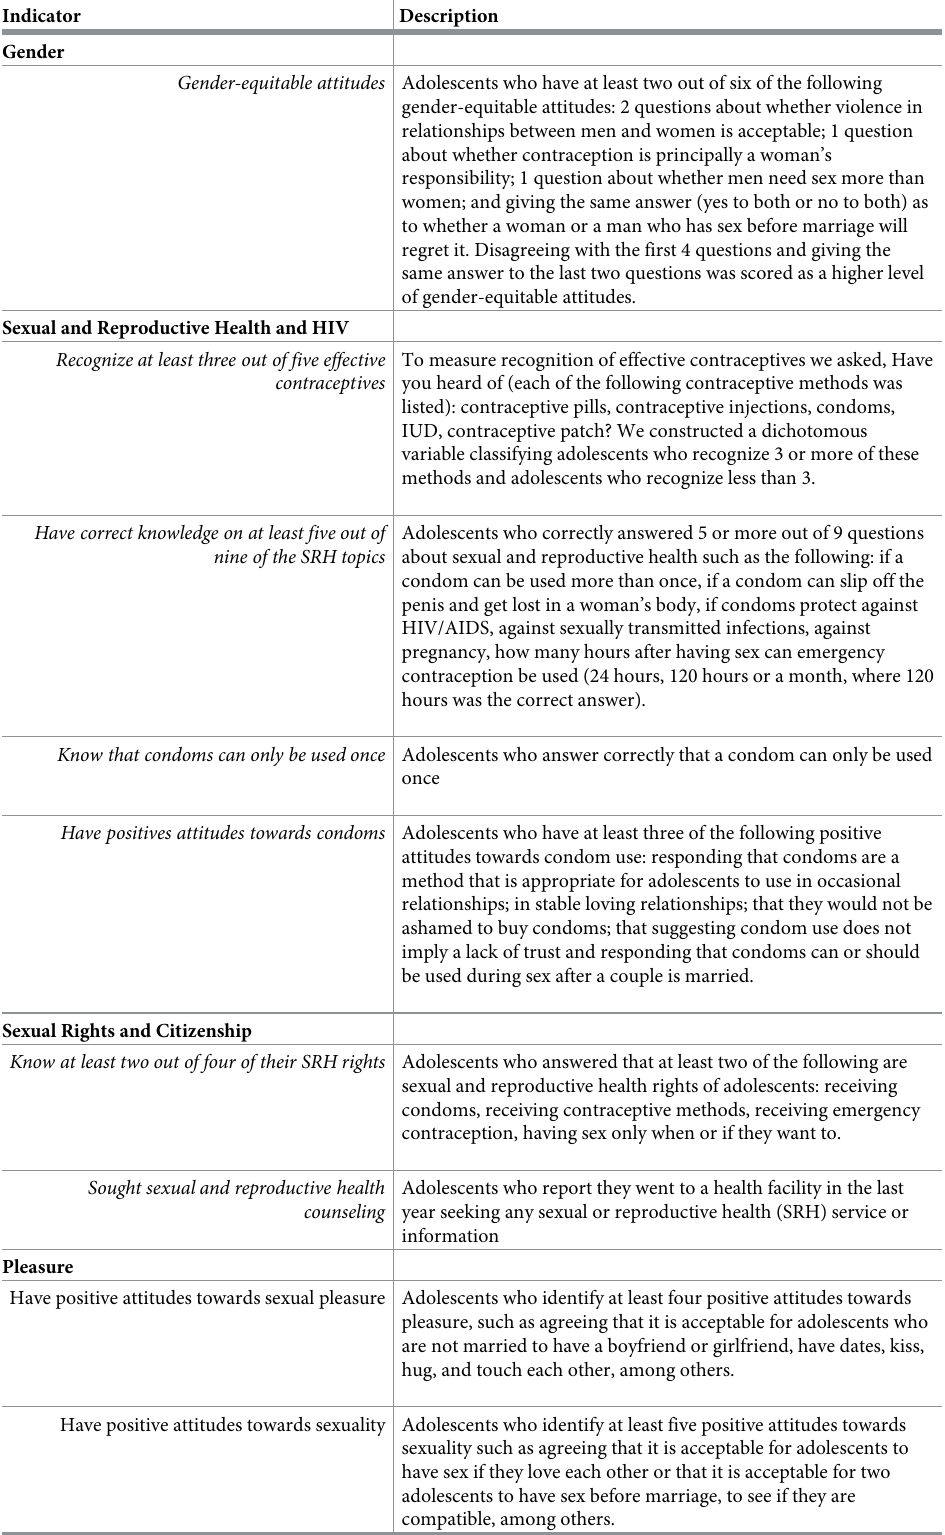
Table 2. Description of outcomes related to comprehensive sex education (CSE) components, Mexico,